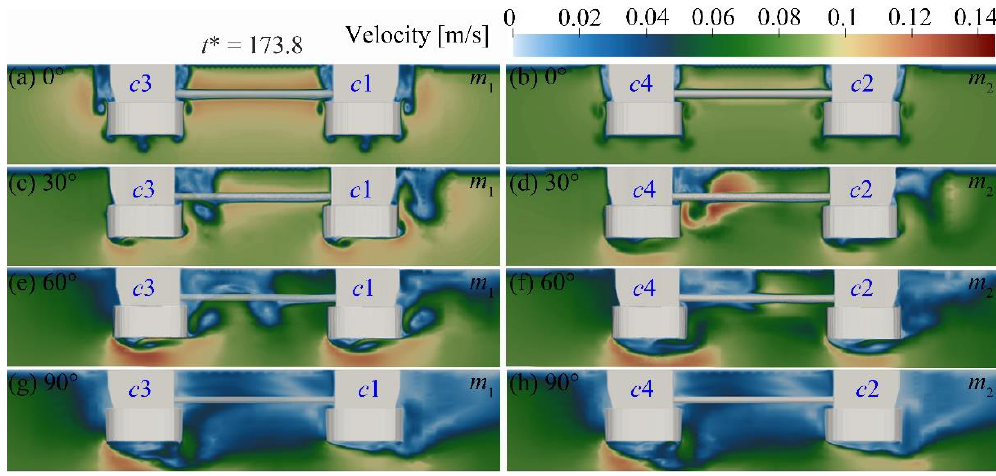
Figure A4. Comparison of the velocity field around the semi-submersible platform at different angles at z = 0.95 m; z = 0.97 m.